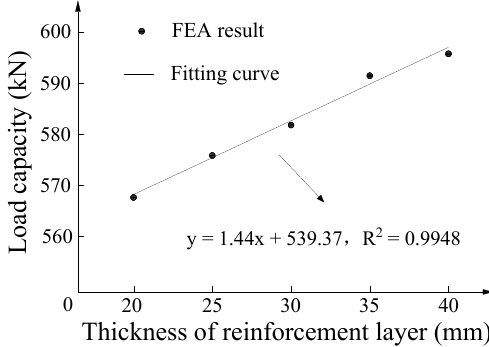
Figure 18. Effect of thickness of reinforcement layer.